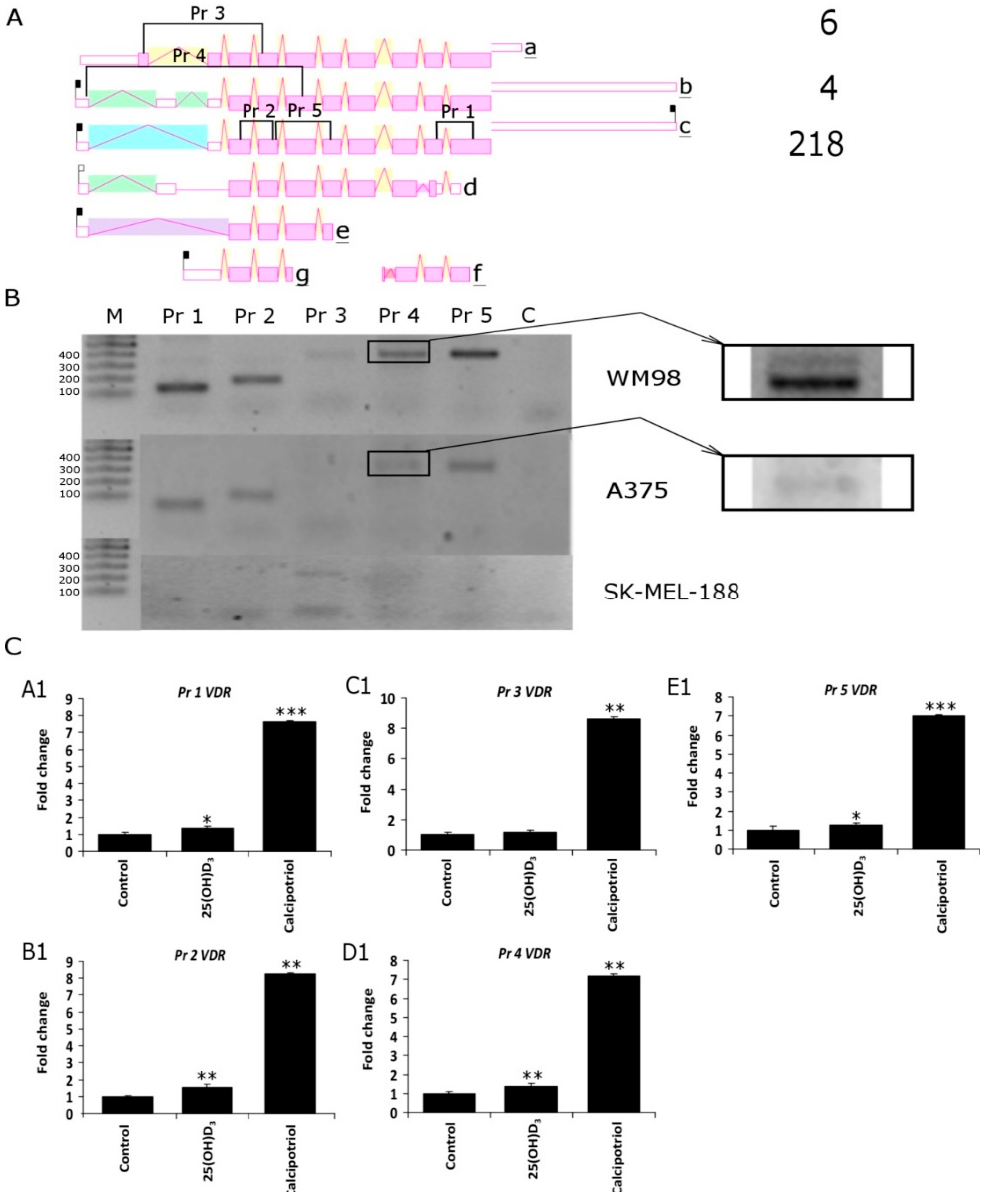
Figure 6. ( A ) Five different PCR primers sets were designed (Pr 1–Pr 5) in order to detect